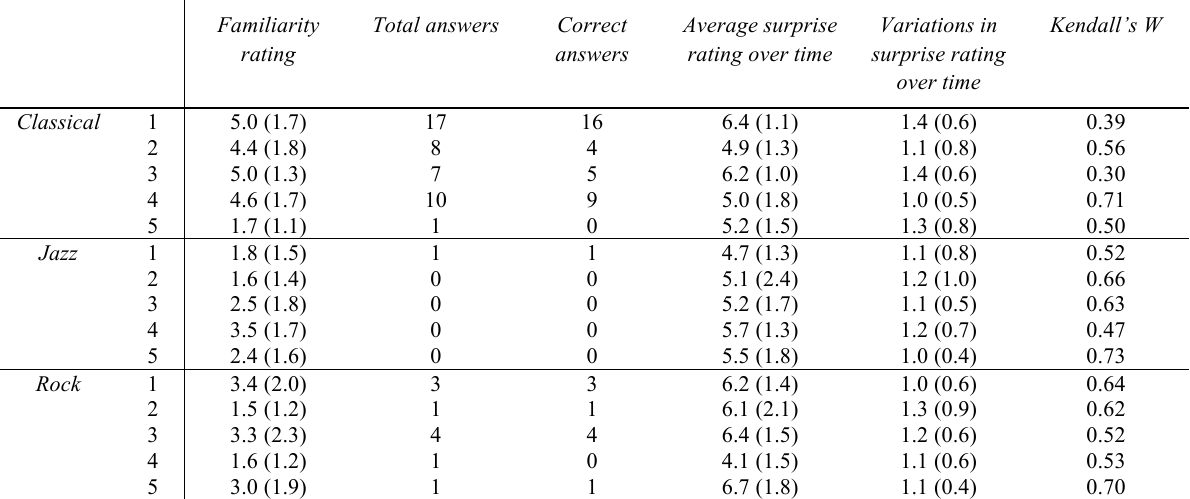
Table 2. Results of familiarity rating, questionnaire, and on-line surprise rating. The first column shows the means of the familiarity rating score across participants, with the standard deviation in parentheses. The second and third columns show the number of participants who gave any answer and a correct one to questions about the excerpt or the artist/composer, respectively. The fourth and fifth columns show the mean of the average and standard deviations of the surprise rating over time, respectively, across participants. Numbers in parentheses are standard deviations across participants. The last column shows the Kendall’s coefficient of concordance (W) of the on-line surprise